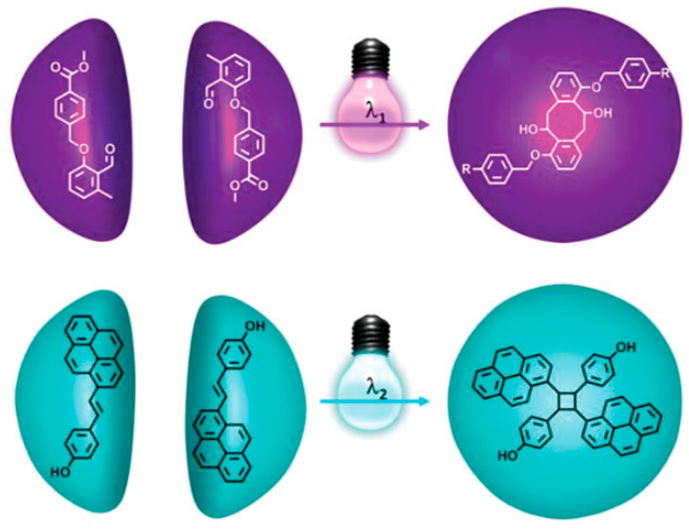
Figure 55. Purple area: o-MBA ( λ 1 maximum = 330 nm purple); turquoise area: StyP ( λ 2 maximum = 435 nm): activations for implementing a λ -orthogonal photoresist. Reproduced with permission from [364]. Copyright © 2022 John Wiley and Sons.